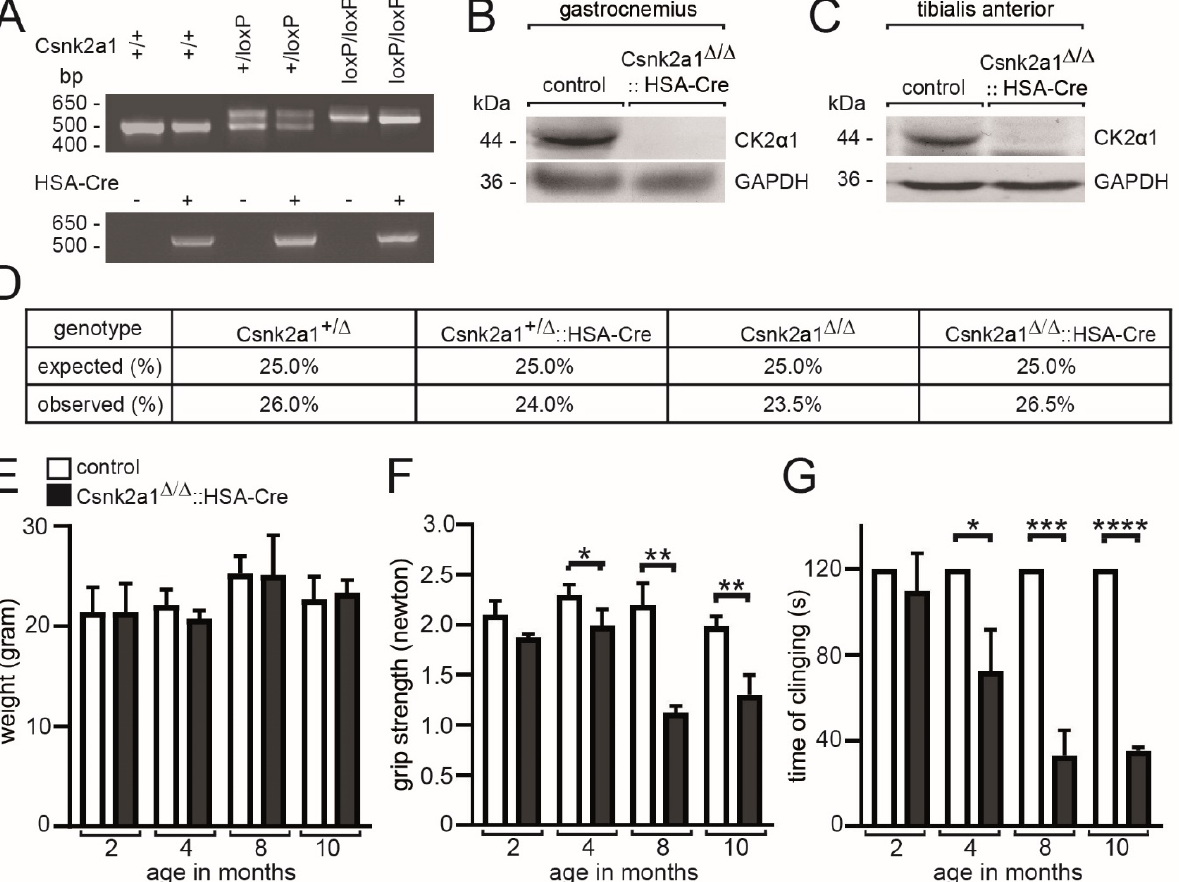
Figure 1. Phenotype of conditional Csnk2a1 knockout mice. ( A ) Agarose gel image shows amplified DNA fragments detected by PCR genotyping of the heterozygous and homozygous floxed alleles of Csnk2a1. Representative images of Western blot membranes reflect the amount of CSNK2A1 and GAPDH protein in gastrocnemius ( B ) or tibialis anterior ( C ) muscle lysates of conditional Csnk2a1 knockout and control mice. ( D ) Expected and observed distribution frequencies of breedings with conditional Csnk2a1 knockout mice are presented. ( E ) Graph presents the body weight of control and conditional Csnk2a1 knockout mice at indicated ages. ( F ) Muscle force is presented by a graph summarizing grip strength for control and conditional Csnk2a1 knockout mice. Note, in comparison with controls, the grip strength of conditional Csnk2a1 knockout mice is gradually reduced starting by the age of 4 months. ( G ) Graph presents muscle force as reflected by the clinging time of mice upside-down on a grid. All labeling of graph bars represents the genotype of mice as indicated in ( E ). Data are represented as mean ± S.D.; n ≥ 3 mice per genotype. **** p < 0.0001, *** p < 0.001, ** p < 0.01, * p < 0.05.